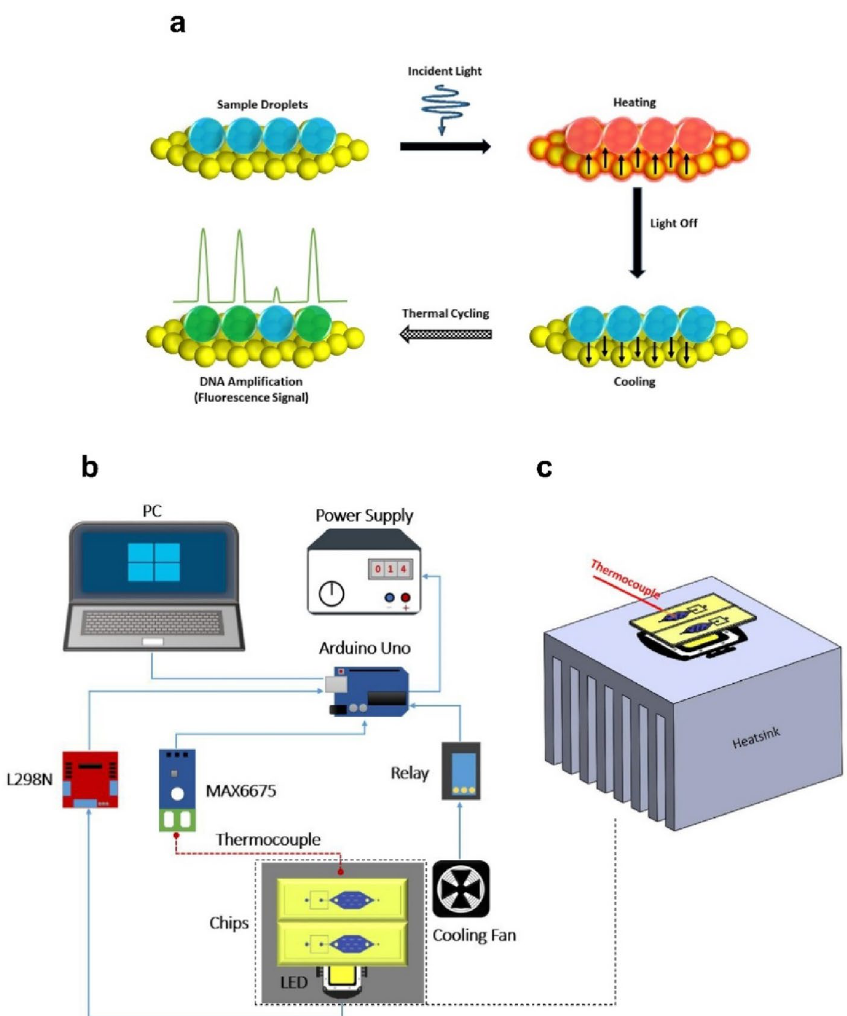
Figure 2. ( a ) Schematic illustration of the fundamental principle of plasmonic photothermal light-to-heat conversion for droplet-based photonic PCR (dpPCR): when a light is turned on, fast heating of sample droplets can be achieved by fast heat diffusion of hot electrons throughout the AuNF. When a light is turned off, the heat dissipation through the AuNF can occur, leading to the cooling of the heated droplets. After thermal cycling, the success of the amplification can be identified by analyzing the fluorescence intensity of droplets. ( b ) Circuit diagram of the plasmonic photothermal cycler. ( c ) An enlarged section of ( b ), indicating the position of the LED, heatsink, chips, and